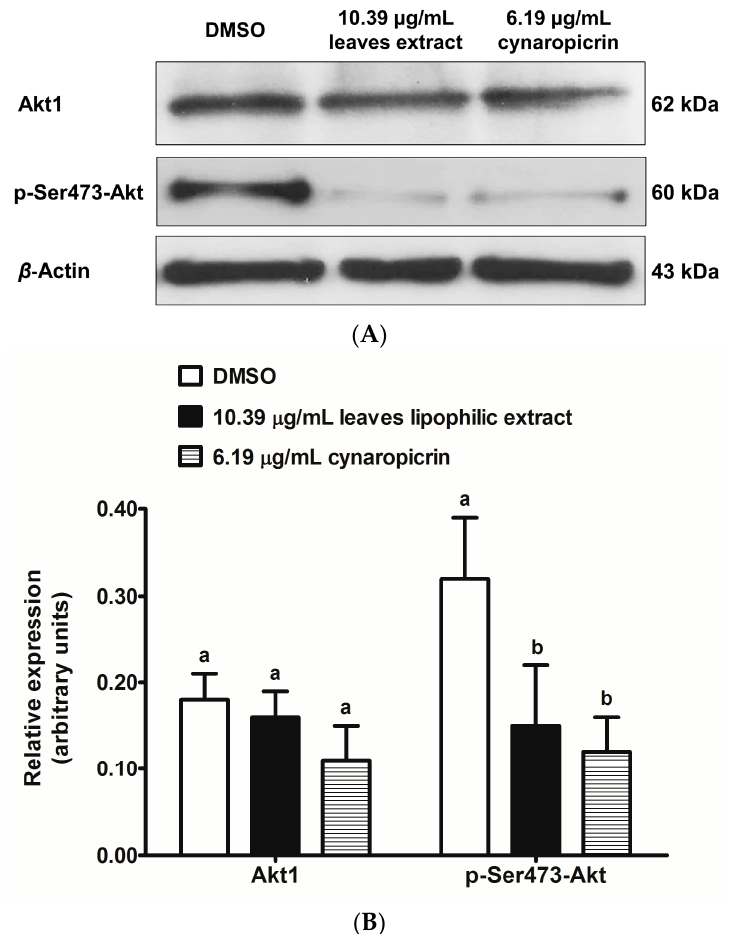
Figure 5. Western blot analysis of Akt1 and p-Ser473-Akt in MDA-MB-231 cells, after 48 h treatments with 10.39 µg/mL cultivated cardoon leaves lipophilic extract and 6.19 µg/mL cynaropicrin. DMSO (0.09% ( v / v )) was used as solvent control. ( A ) Representative image of immunoblots; ( B ) Relative expression determined by analysis of band integrated density and normalization to β -actin. Each column and bar respectively represents the mean and the standard deviation of three independent experiments. Columns of each protein with different letters are statistically different ( p < 0.05).